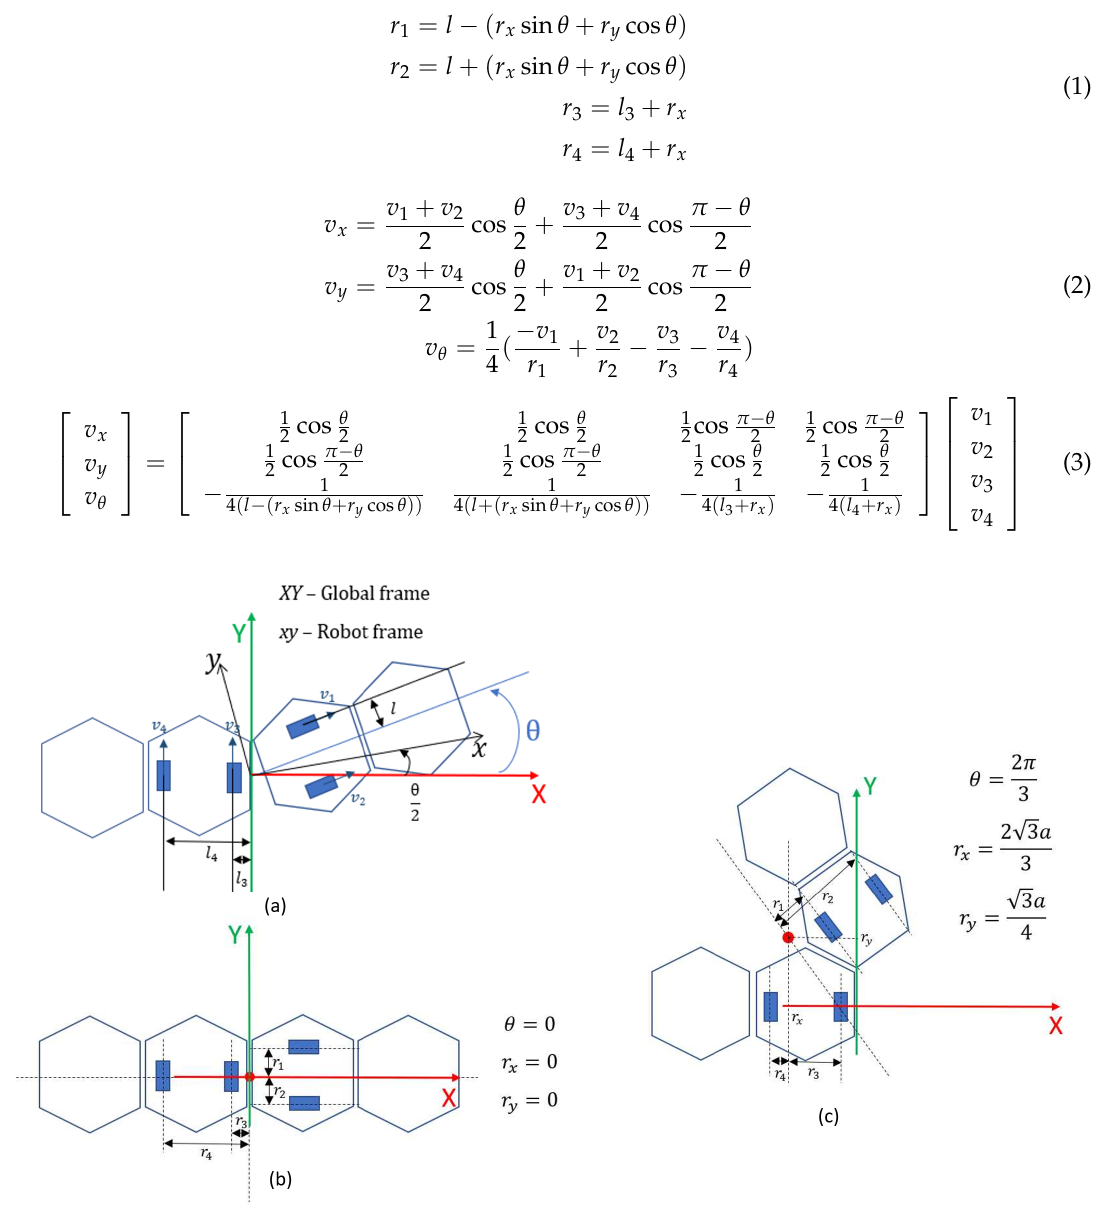
Figure 8. Schematic diagram of the hHoneycomb platform showing the wheel layout and coordinate frames at an arbitrary orientation, ( b ) values of r x , r y , and θ of the bar configuration, ( c ) values of r x , r y , and θ of the arch